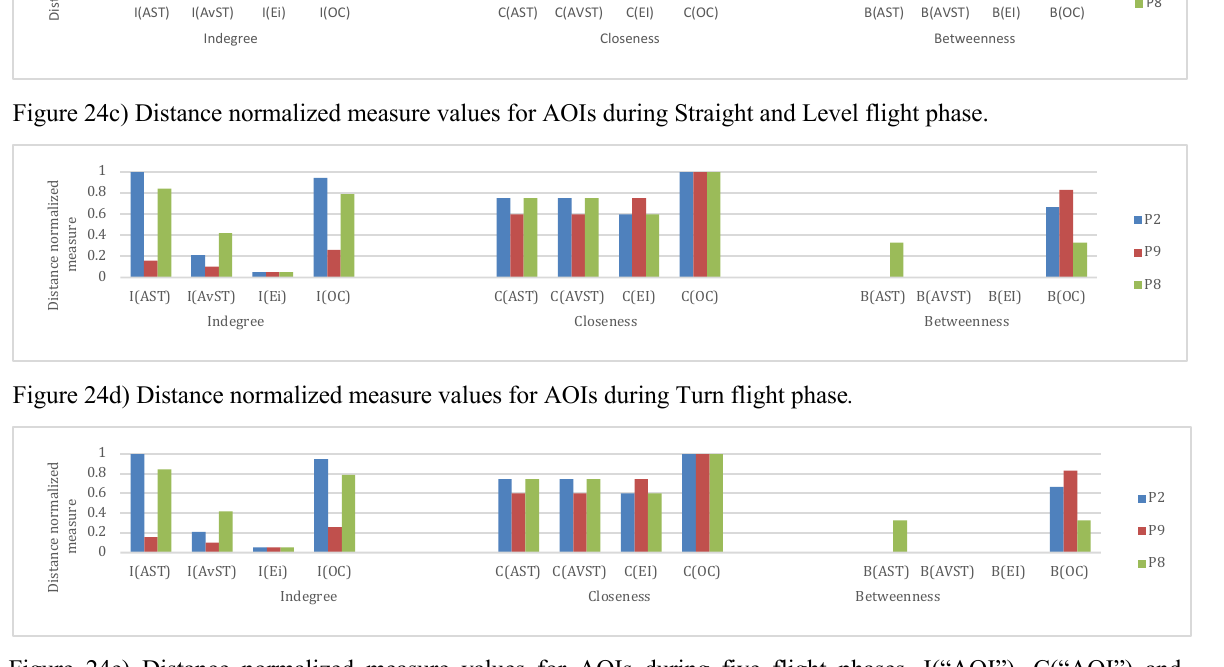
Figure 24e) Distance normalized measure values for AOIs during five flight phases, I(“AOI”), C(“AOI”) and B(“AOI”) refers to normalized indegree, closeness and betweenness values, respectively. Different participants are represented with different